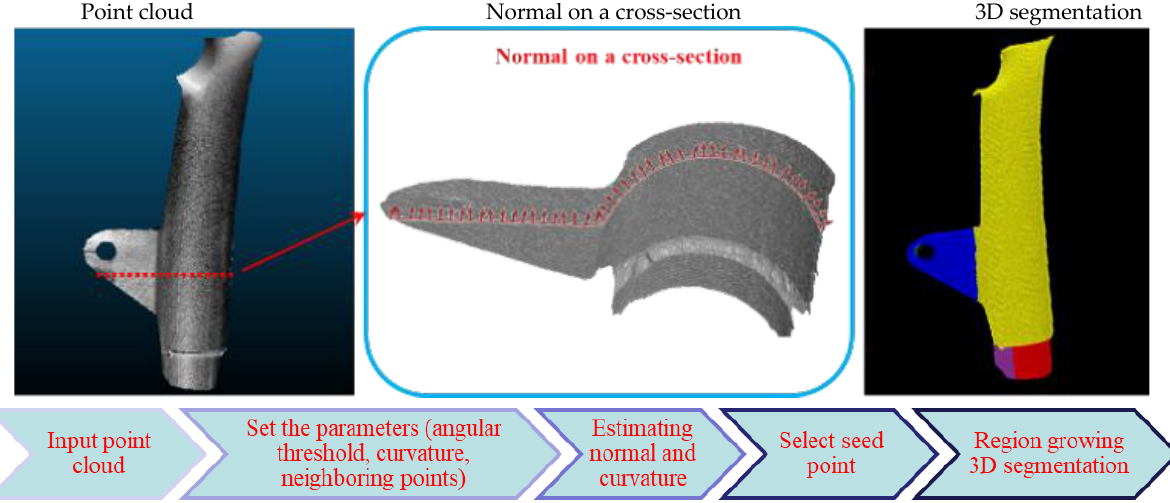
Figure 6. Schematic view of the region growing 3D segmentation approach (Method B). Each color represents a different segment.